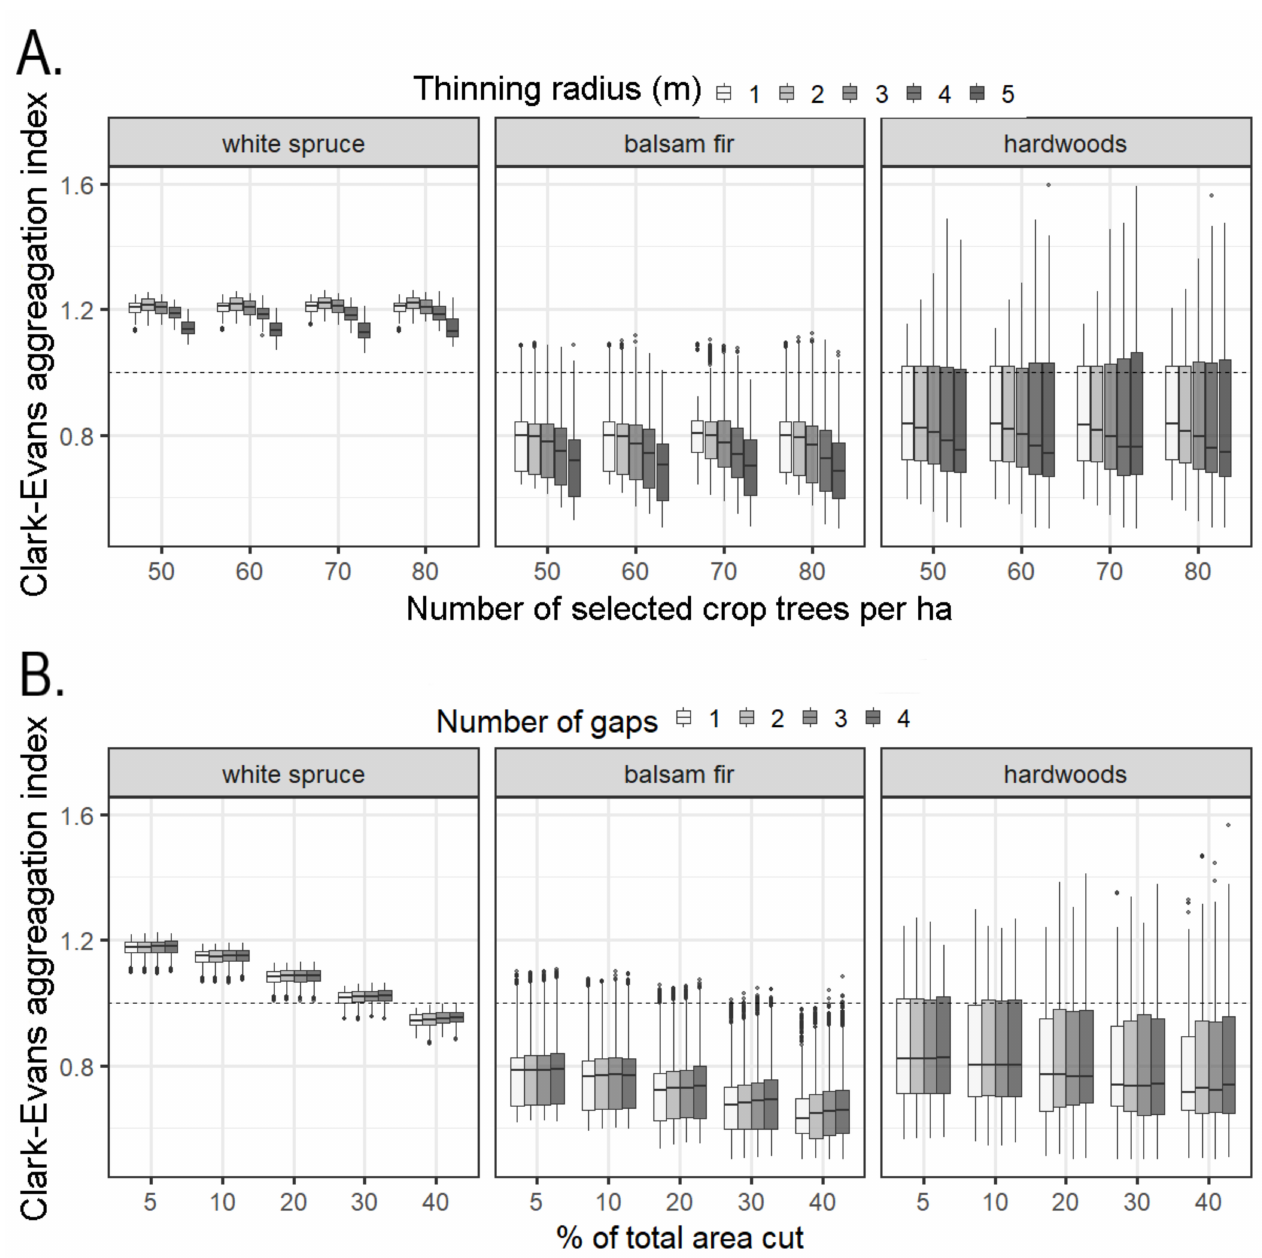
Figure 6. Variation of the Clark and Evans aggregation index for each species group (Gsp) after simulating ( A ) the number of crop trees selected per hectare, with various clearance distances (thinning radii) around each tree, and ( B ) the proportion of the total area that was cut, with a variable number of gaps. See Table 2 for definitions of Gsp and treatment